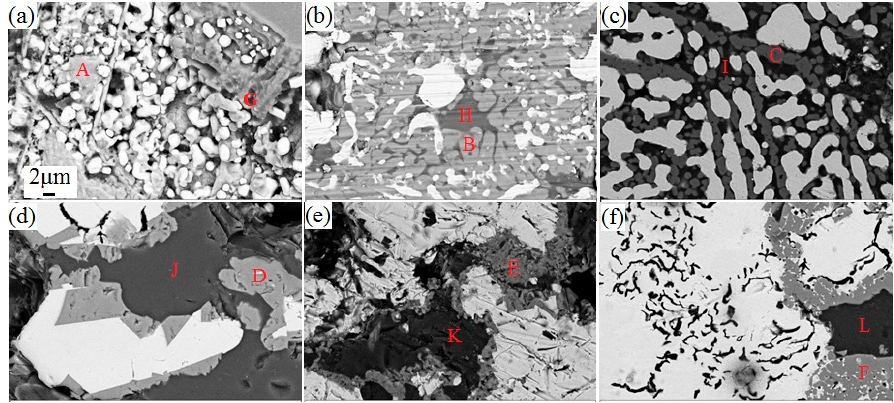
Figure 5. The effect of temperature on the microstructure of reduced LGVTMP at 5000×: ( a ) 1100